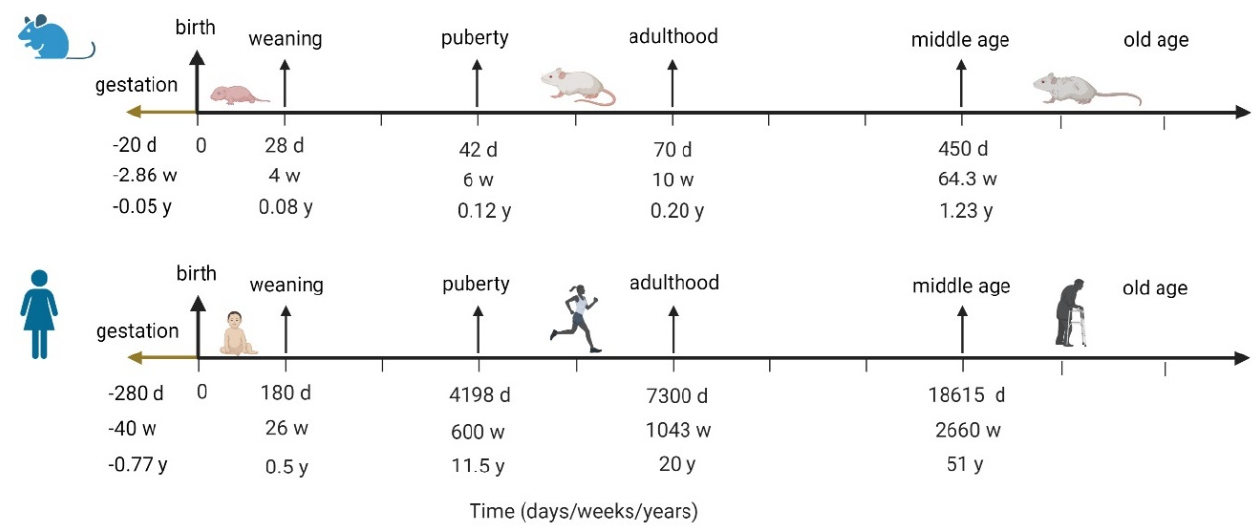
Figure 2. Aligning human and mouse lifespans by developmental milestones; the figure visualizes analysis done by Dutta et al. in [16].